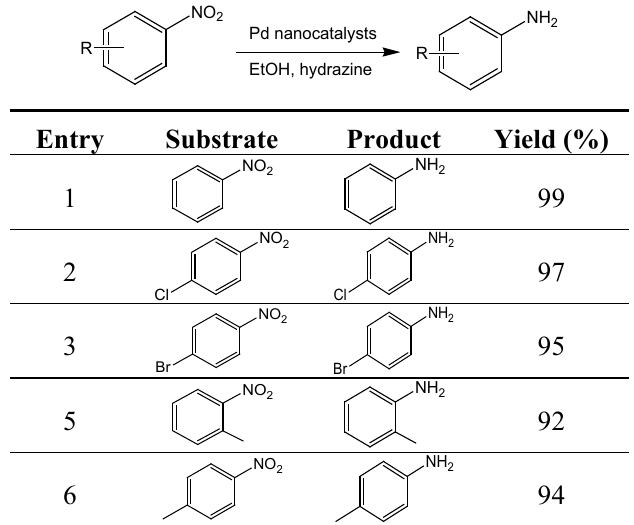
Table 6. Heterogeneous reduction of substituted nitrobenzene. Reprinted with permission from [69].